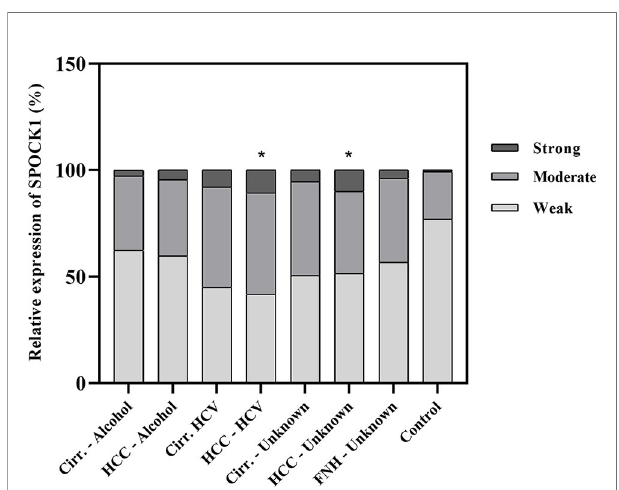
FIGURE 2 | Quantitative assessment of the expression of SPOCK1 protein in liver cirrhosis and cancer of various origins. Signi fi cant increase in cancer specimens. n = 76, *p <